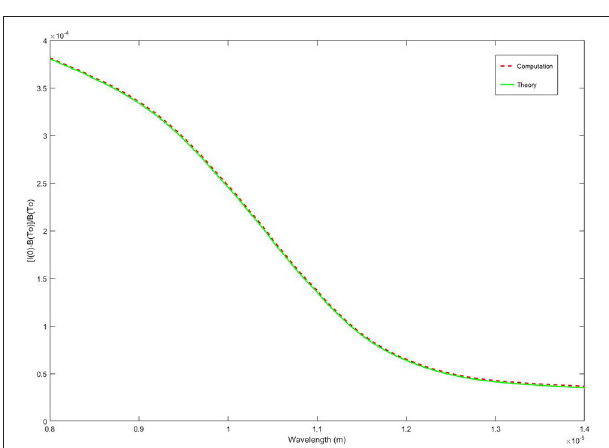
FIGURE 3 | Comparison of numerical result to theoretical approximation over the entire long-wave